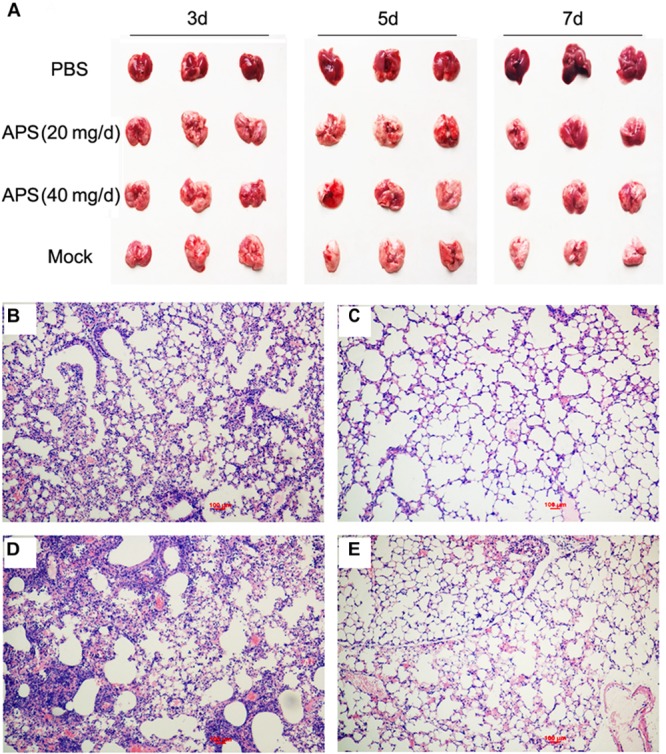
Aloe polysaccharides reduces the pathological change of infected lungs. All mice in groups I, II, and III were infected intranasally with the 105 TCID50 of virus. Then the mice in groups I and II were orally administrated with 20 and 40 mg of APS per day, respectively, and group III were orally administrated isometric PBS. The virus-free mice in groups IV served as the normal control. At 7 dpi, the lungs in each group were collected, and the pulmonary lesions (A) and pathological changes (B, group I; C, group II; D, group III; E, group IV) were compared through subjective observation and H&E staining, respectively. Scale bar, 100 μm.